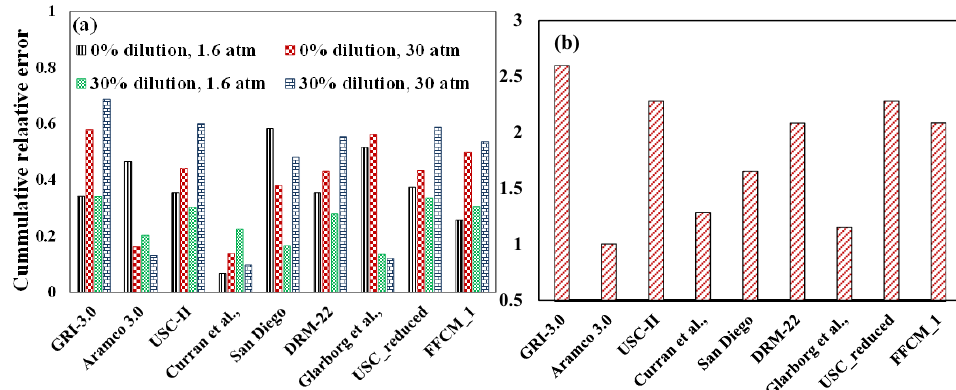
Figure 5. The cumulative relative error for different mechanisms for ( a ) cases with no and high dilution and 1 atm and 30 atm of Donohoe et al. and ( b ) combined dilution cases reported in the literature.